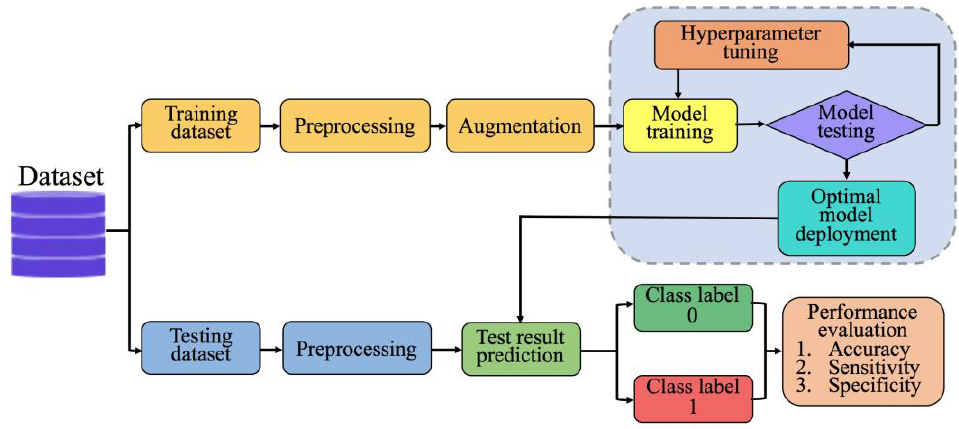
Figure 4. Schematic of the classification process.